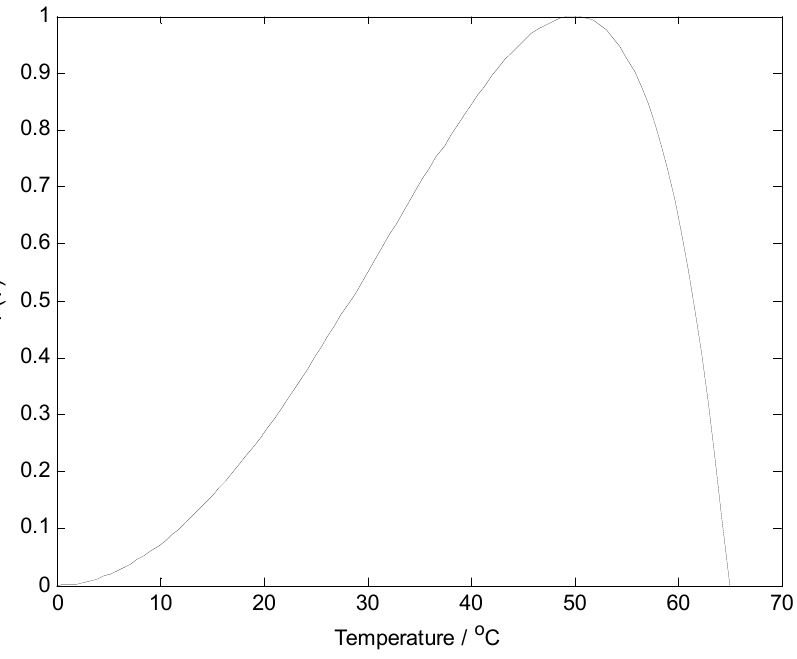
Figure 1. Temperature influence factor changes with temperature. The effect of moisture content is mainly reflected in the ability of microorganisms to use nutrients and its effect on reducing air-permeable space. Haug (1993) proposed the correction formula of water content on degradation rate. Petric et al. (2015) used it to simulate the compost degradation process, and the results showed that the formula had a good fitting effect on moisture content. The water content is between 0 and 0.3, and the water content influence factor changes slowly at less than 0.1; the water content is between 0.3 and 0.6, showing a non-linear and rapid growth; and the water content is greater than 0.6, slowly approaching 1 (Figure 2).